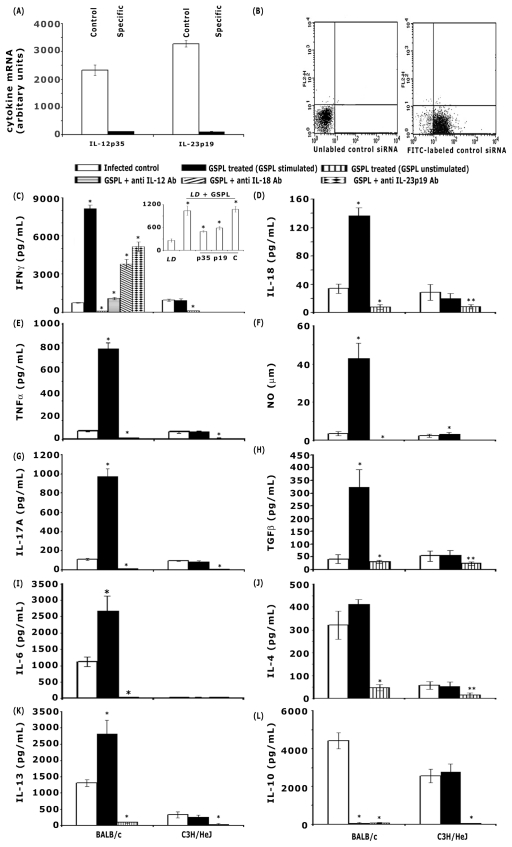
GSPL treatment induces iNKT cell mediated Th1/Th17 cytokines in BALB/c.iNKT cells isolated from experimental animals were mixed with autologous splenic adherent cells as described for Figure 4. Cells were stimulated with GSPL at 100 µg/mL for the time periods as mentioned in the text. Cytokines and NO in spleen cell culture supernatants of five individual animals from each group were determined by ELISA and Greiss assay method, respectively. (A) Splenic adherent cells were transfected with siRNAs specific to IL-12p35 or IL-23p19 (cytokine). A control group was transfected with control siRNA (c). Twenty-four hours after transfection, cells were recovered and their cytokine levels assessed by real-time PCR. GAPDH in total proteins was used as loading controls. Data is the representative of three separate experiments. (B) Transfection efficacy was quantified using FITC-labeled scrambled siRNA control and flow-cytometry. (C) Requirement of IL-12 and related cytokines in IFN-γ production by collaboration between Vα14+ NKT cells and APCs. Anti IL-12p70, anti IL-18 and anti IL-23p19 Abs or isotype controls (data not shown) were added to parallel cultures and IFN-γ production was assessed in the supernatant by ELISA. Adherent cells were transfected with IL-23p19, IL-12p35 and control siRNA and IFN-γ production was assessed (C, insert). D, IL-18; E, TNF-α; F, NO; G, IL-17A; H, TGF-β; I, IL-6; J, IL-4; K, IL-13 and L, IL-10 expressions. Data represent the mean ± SD for five animals per group. (*p<0.0001 versus corresponding infected control; paired two-tailed Student's t-test). Data are representative of three experiments.